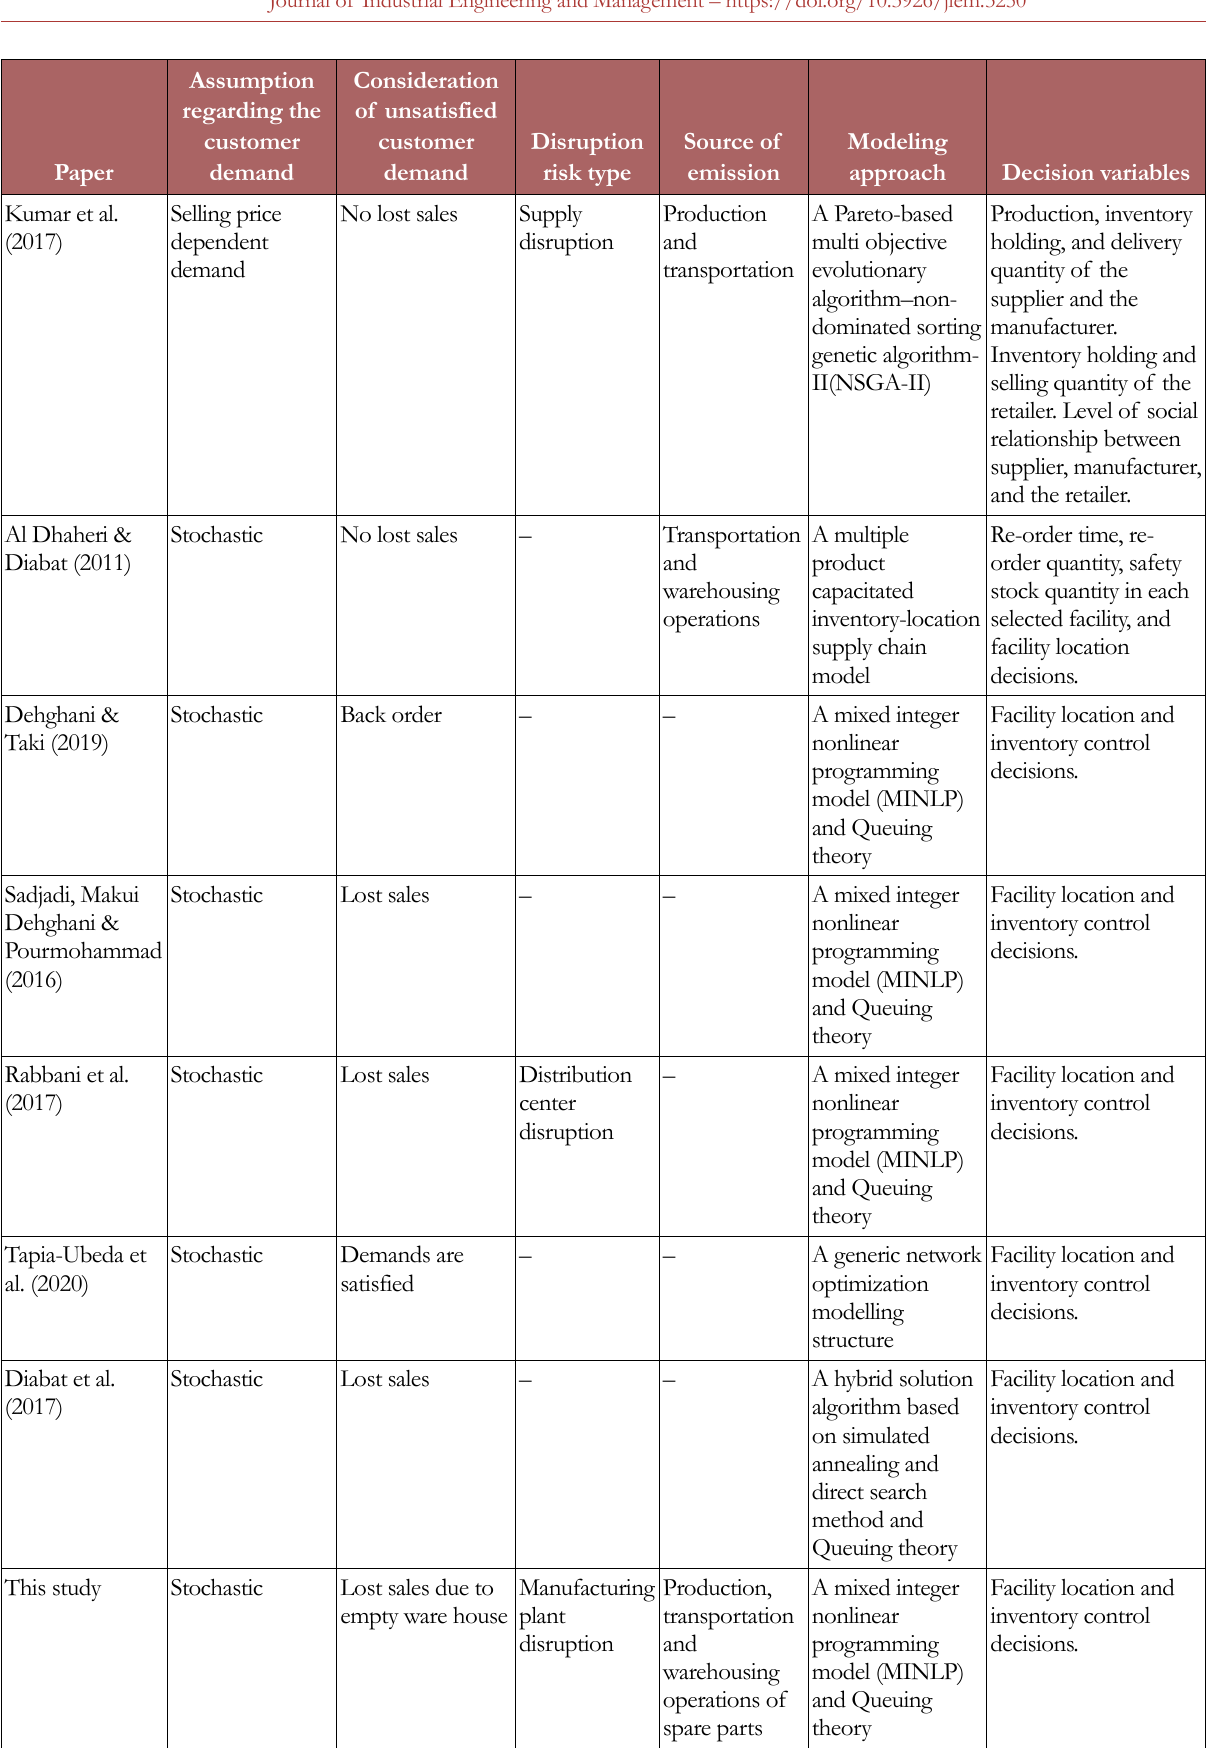
Table 1. Literature review